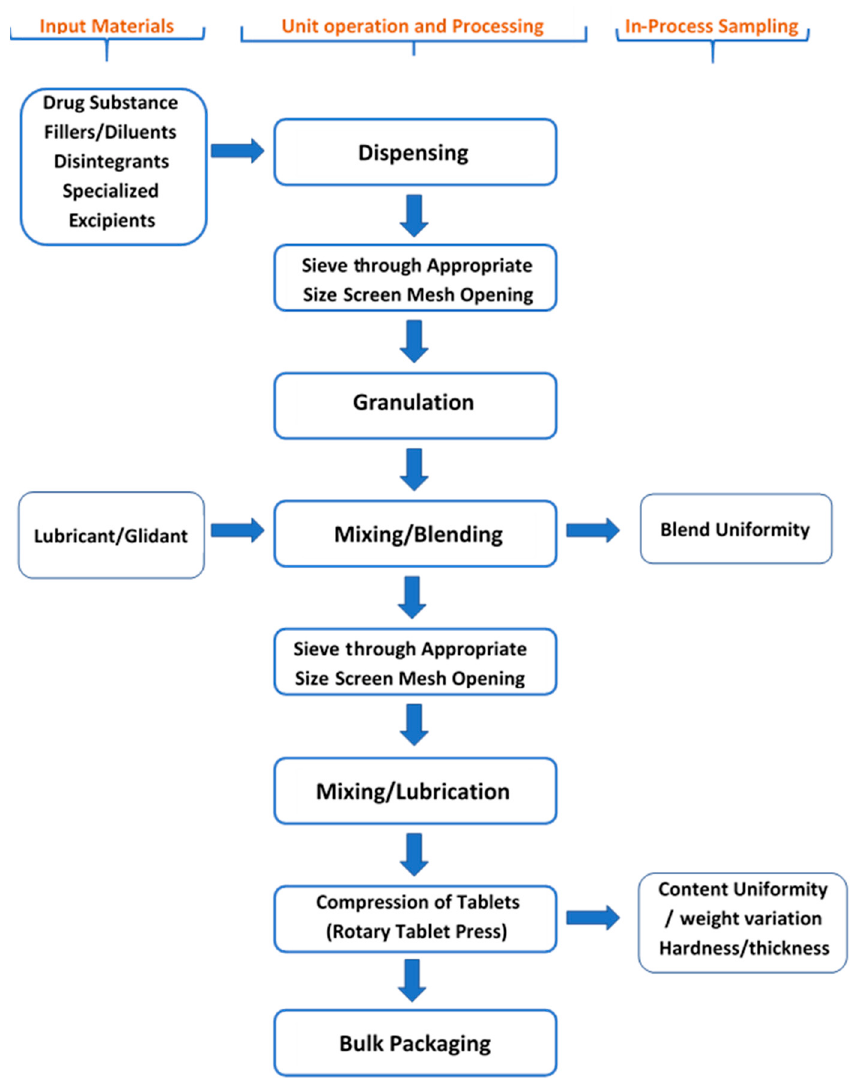
Figure 5. Process flow diagram which highlights various steps during tablet manufacturing.